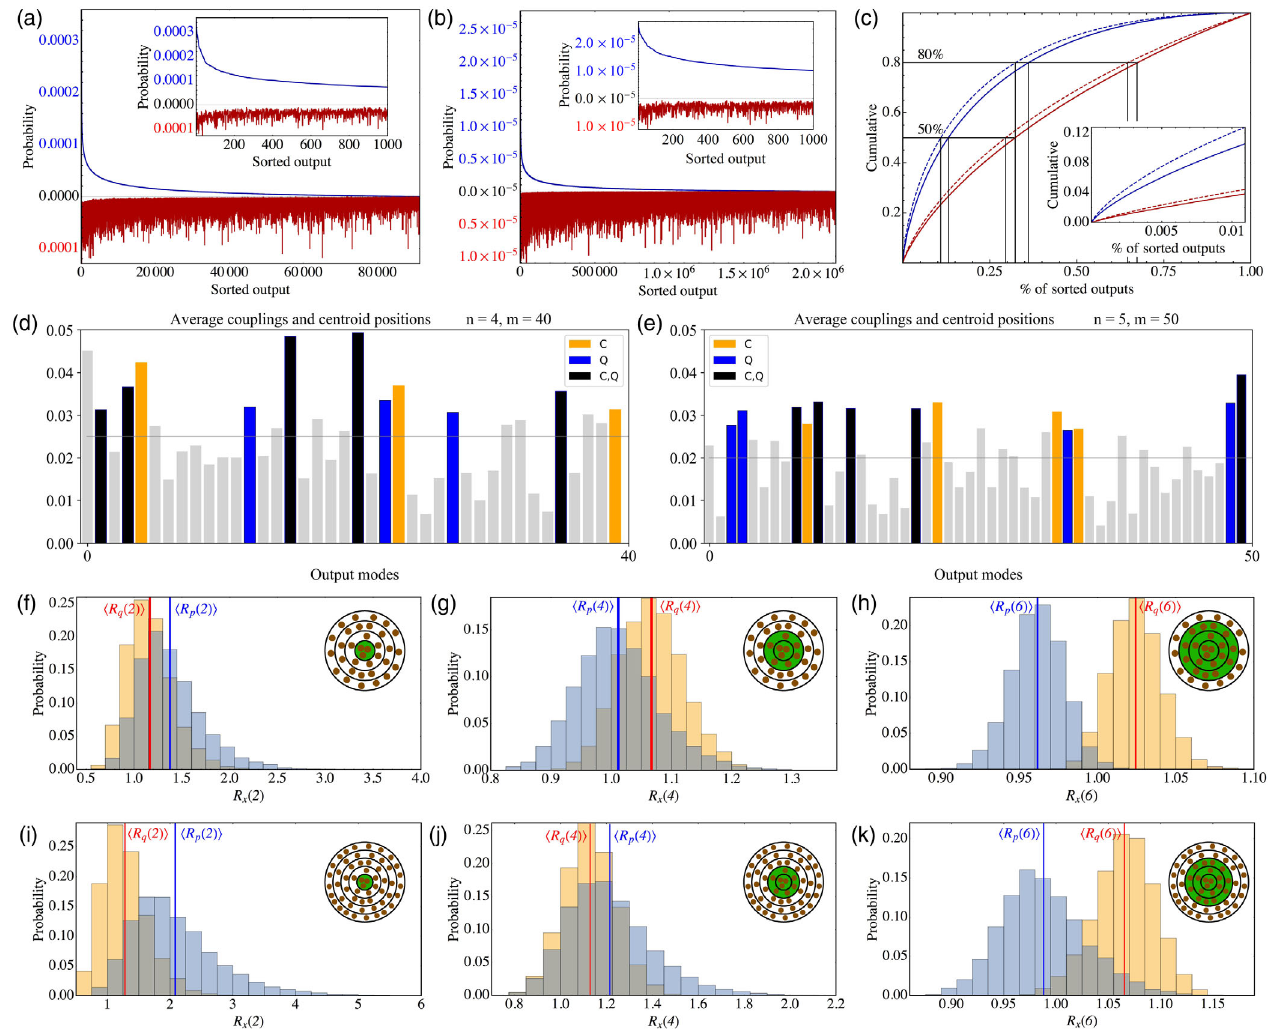
FIG. 5. Analysis of the structure of the distributions. (a),(b) Probability distributions for a fixed unitary U in the case of indistinguishable (blue) and distinguishable (red) photons. (a) n ¼ 4 , m ¼ 40 and (b) n ¼ 5 , m ¼ 50 . The distributions are sorted by following the same ordering so as to have decreasing probability values for the indistinguishable distribution P i . Inset: Enlargement corresponding to the 1000 most probable output states. (c) Cumulative distributions for indistinguishable (blue) and distinguishable (red) photons, by following the same ordering as (a),(b). Solid lines, n ¼ 4 , m ¼ 40 . Dashed lines, n ¼ 5 , m ¼ 50 . Black lines highlight the levels corresponding to 50% and 80% of the overall probability, which require approximately twice the number of output states in the distinguishable case. Inset: Enlargement corresponding to the 0.01% most probable output states. (d),(e) In the m -dimensional vector space where K means is performed on quantum (Q) and classical (C) samples, centroids tend to be located where the output modes have a high probability averaged over the input modes. This property is signaled by a vector with one coordinate, out of m for a Fock state, significantly higher than the others. Zeroing the small ones out yields a plot analogous to the one shown here for ten clusters with (d) n ¼ 4 , m ¼ 40 and (e) n ¼ 5 , m ¼ 50 . (f) – (k) Histograms of the ratios R p ð k Þ (cyan) and R q ð k Þ (orange) between the overall probability included within a sphere of L 1 -norm ≤ k . (f),(h) n ¼ 4 , m ¼ 40 . (i) – (k) n ¼ 5 , m ¼ 50 . Vertical lines correspond to the averages h R x ð k Þi , with x ¼ p (blue) and x ¼ q (red). (f),(i) k ¼ 2 , (g),(j) k ¼ 4 , and (h),(k) k ¼ 6 . Insets: Schematic view of the spheres at a distance ≤ k , represented by concentric circles, where states are represented by brown